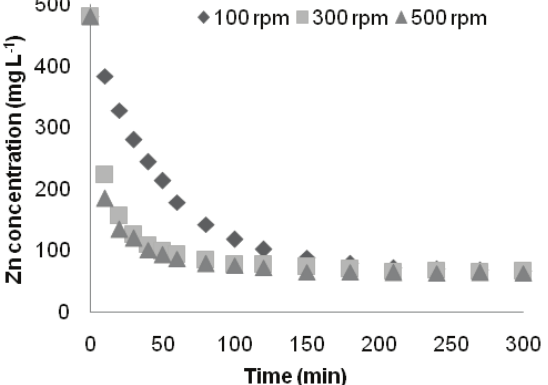
Figure 2. Effect of stirring rate on zinc sorption by Amberlite IRA410; C